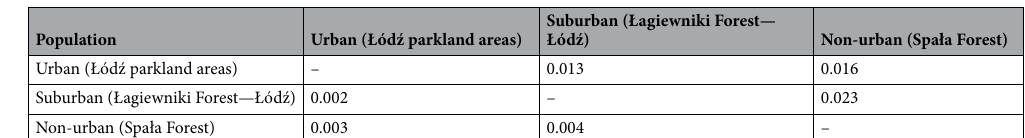
Table 5. Matrix of pairwise F ST (below diagonal) and F ′ ST (above diagonal) estimates for ten microsatellite loci between studied populations of the blue tits. Urban, suburban and non-urban populations are represented by individuals sampled in Łódź parkland areas, Łagiewniki Forest, and Spała Forest, respectively.